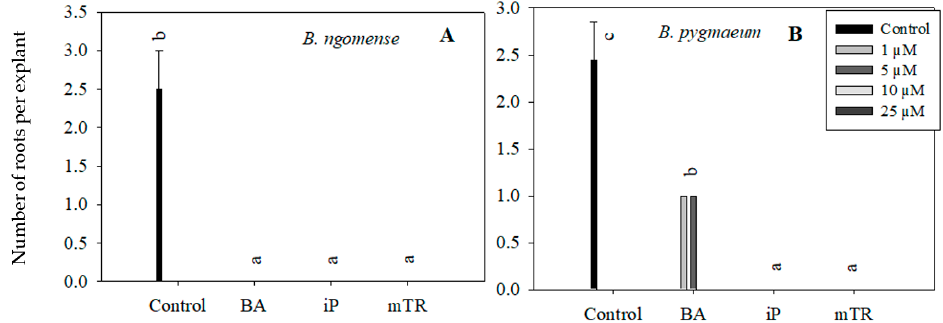
Figure 5. Effect of varying concentrations of cytokinins on the number of roots in ( A ) Brachystelma ngomense and ( B ) Brachystelma pygmaeum after six weeks in culture. In each graph, different letter(s) on the bars show significant differences according to Duncan’s multiple range test (DMRT) ( p ≤ 0.05). N 6 -benzyladenine (BA), isopentenyladenine (iP) and meta -topolin riboside ( m TR).